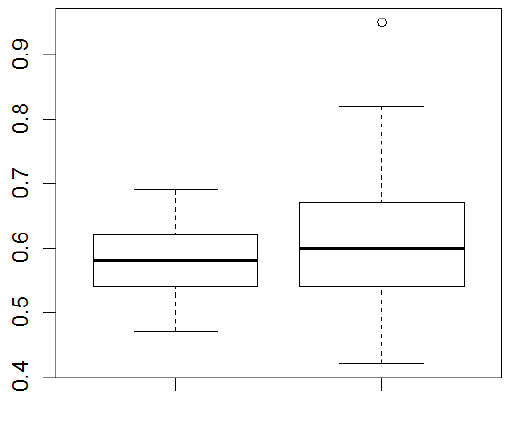
Figure 2. WHtR values f or males and females. Wilcoxon test for the comparison of the means; p <